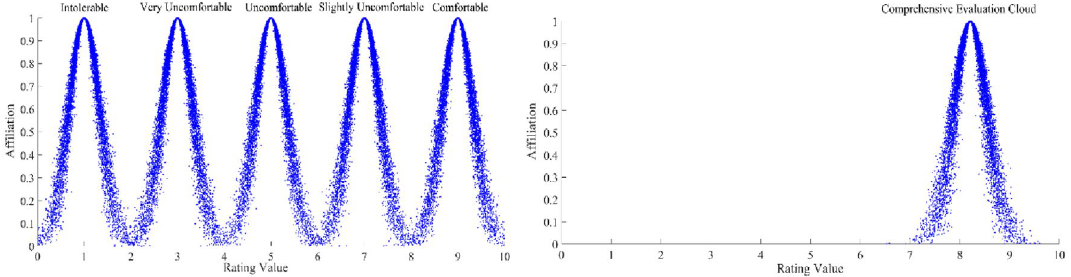
Figure 3. ( a ) Standard evaluation cloud; ( b ) Comprehensive evaluation cloud. Standard evaluation cloud